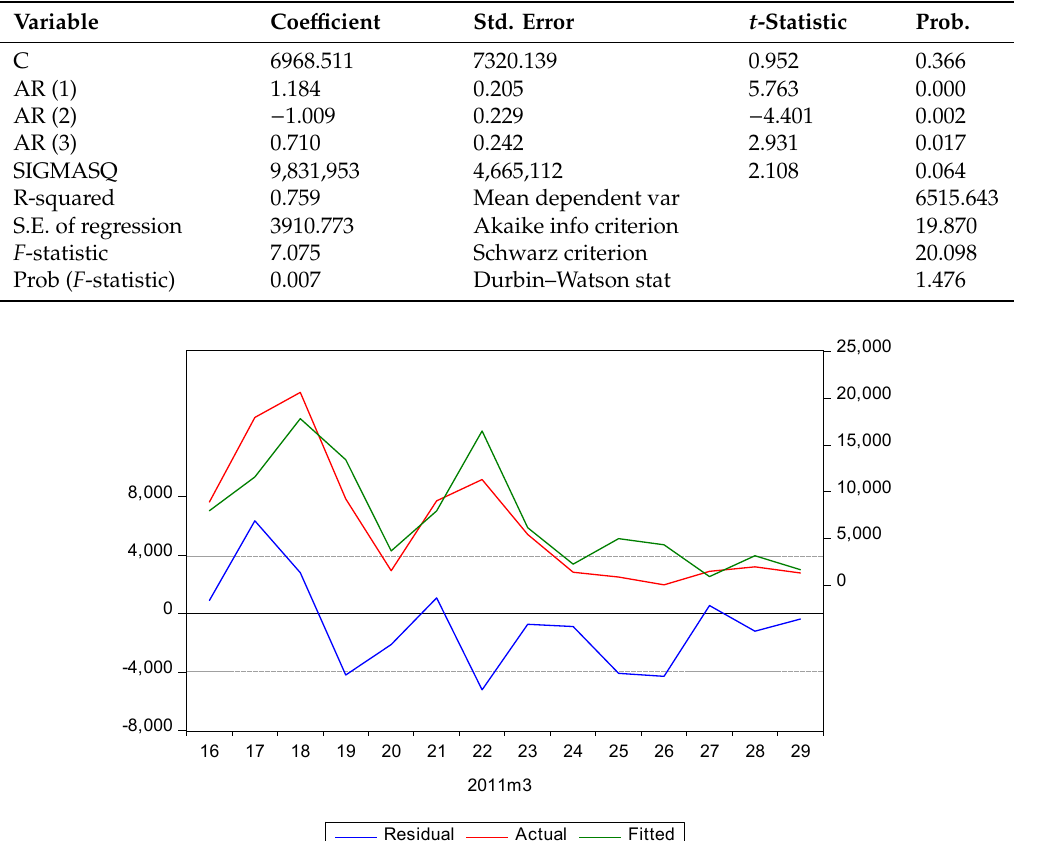
Figure 8. The fit figure of Alpha rice estimated by ARIMA.